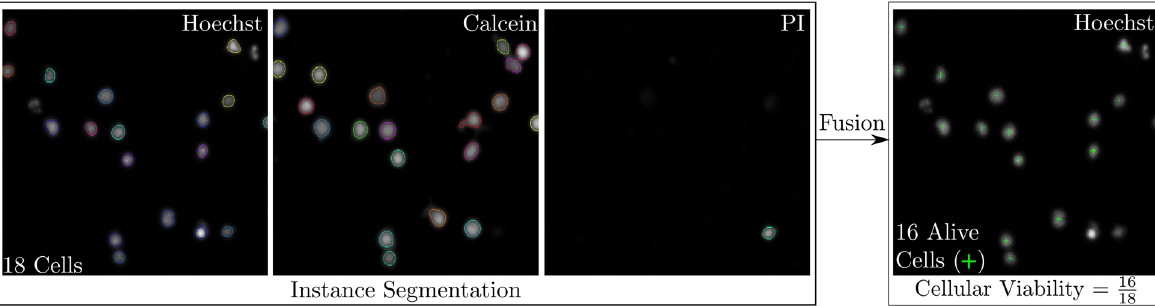
Figure 12. Automated Cellular Viability Analysis. The detected instances in the different stainings (Hoechst, Calcein, PI) are visualized by marking the boundaries. Thereby, different instances are encoded by changing colors. At the end of the fusion step, live cells (Hoechst positive, Calcein positive, PI negative) needed to obtain cellular viability are marked with a green cross. For reasons of visualization and clarity, the images shown represent only a crop of an entire DMA spot.